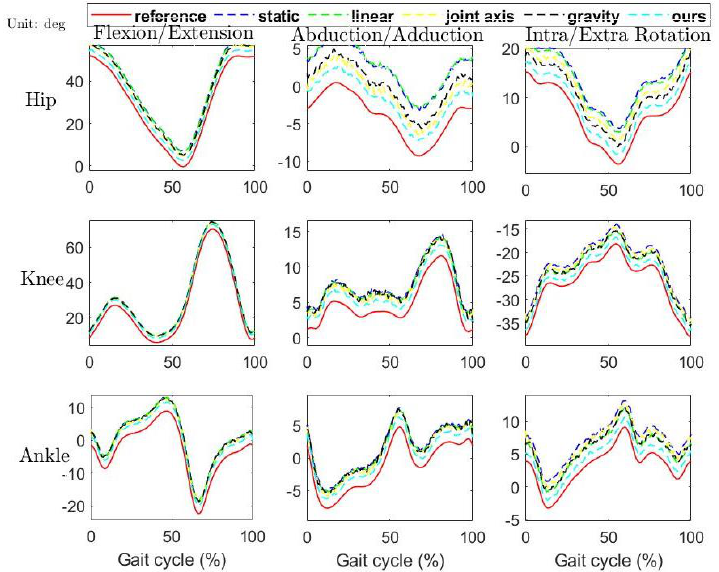
Figure 10. Sample plots of the 3-dimensional joint angle curves estimated by employing all the five RFU methods, where “static” denotes the static RFU method [28], “linear” denotes the linearly interpolted RFU method [23], “joint axis” denotes the joint axis-based RFU method [29], “gravity” denotes the gravity acceleration based method [13] and “ours” denotes the RFU method proposed in this